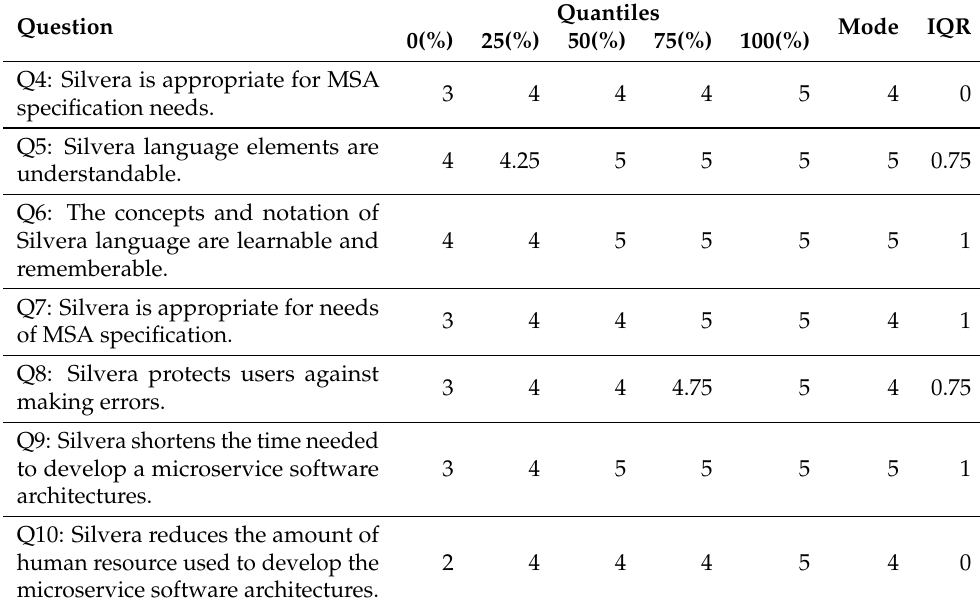
Table 17. Analysis of central tendency and dispersion of the responses (n = 18). Values for me- dian and mode show the central tendency, while Inter-Quartile Range (IQR) shows the dispersion of the